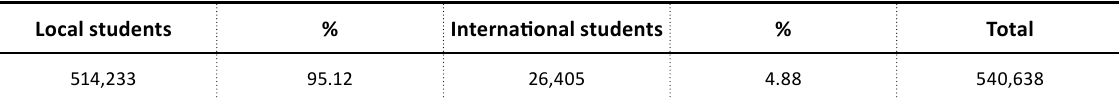
Table 8. Enrolment and percentage of international students at public higher education institutes Source: Planning, Research and Policy Coordination Division, MOE (2016).